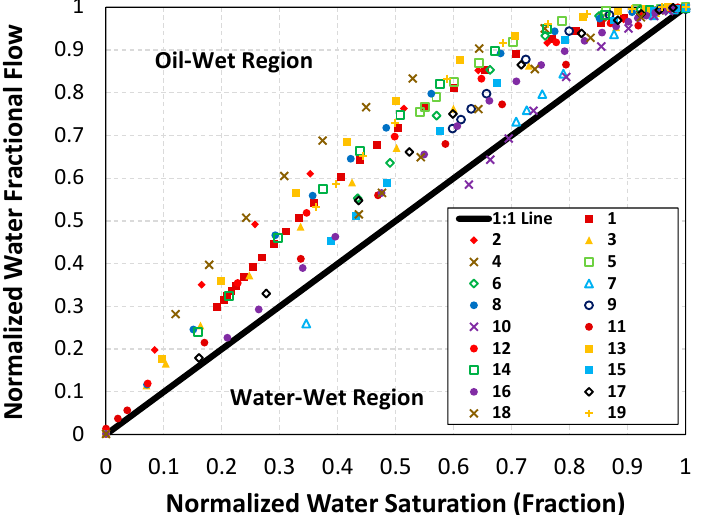
Figure 4. Normalized water fractional flow, Equation (7), against normalized water saturation, Equation (8), for all the 19 samples studied here. The solid black line indicates the 1:1 line. The relative permeability measurements were used to evaluate Craig’s rules of thumb and the modified Craig’s second rule, plot the normalized water fractional flow curves, and calculate the values of Lak and modified Lak indices (Table 4). As Table 4 indicates, the results of Craig’s second rule and those of the modified Craig’s second rule are in agreement for all samples except samples 7 and 10. For these two samples other indicators show water-wet conditions. While Craig’s second rule characterizes these samples as oil-wet, the modified Craig’s second rule labels them as water-wet. Furthermore, Craig’s third rule also provided results inconsistent with the others. Although Craig’s third rule predicted water-wet conditions, other indices recommend oil-wet. Such inconsistencies have been previously reported by Mirzaei–Paiaman [15]. Since the results of Craig’s second and third rules are inconsistent with those of other approaches, we excluded them from further Table 4. Results of wettability evaluation by the relative permeability-based methods.